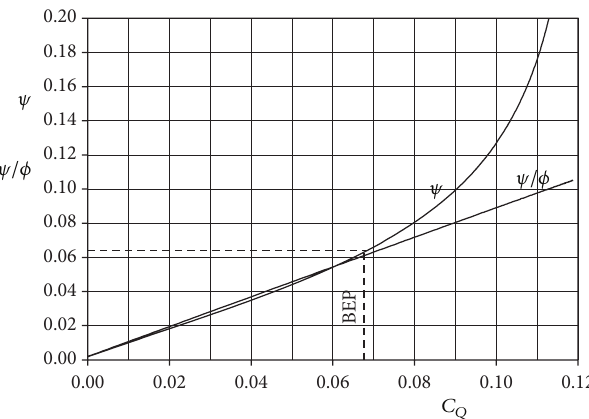
Figure 11: Variation of flow coefficient and ratio of flow coefficient to speed coefficient with discharge coefficient.